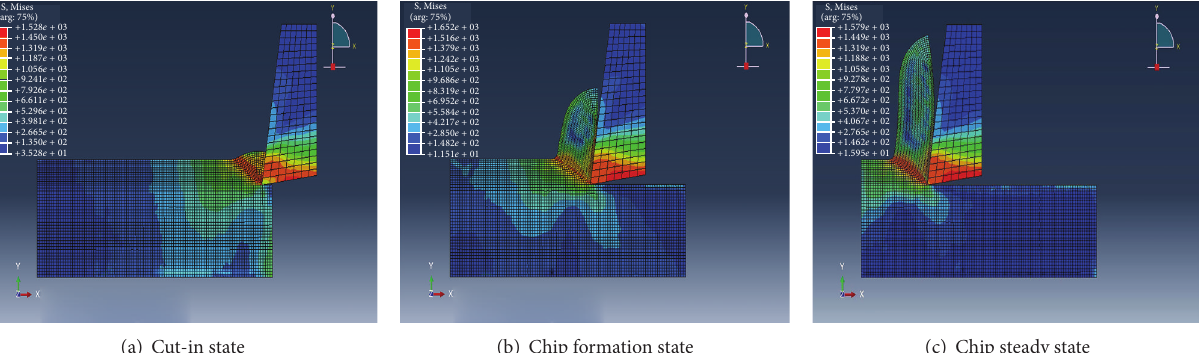
Figure 4: The stress distribution of cutting speed of 254 m/min.